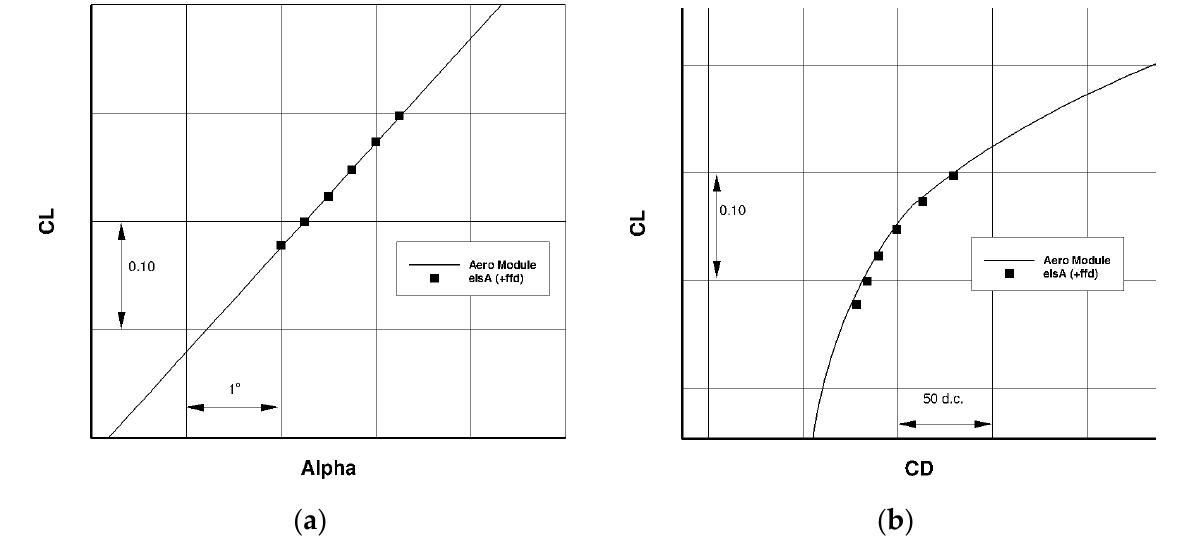
Figure 30. AVECA BWB configuration—global aerodynamic performances (M = 0.85, Re = 180 × 10 6 ). Lines—aerodynamic module; symbols—CFD. ( a ) C L ( α ). ( b ) C L( C D ).